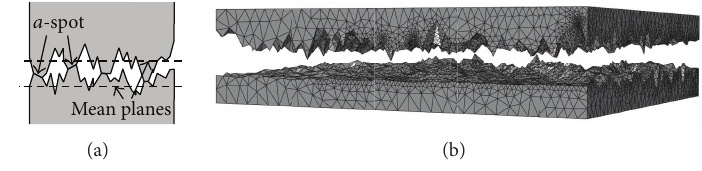
Figure 2: (a) Effective contact area; (b) typical fractal surface.